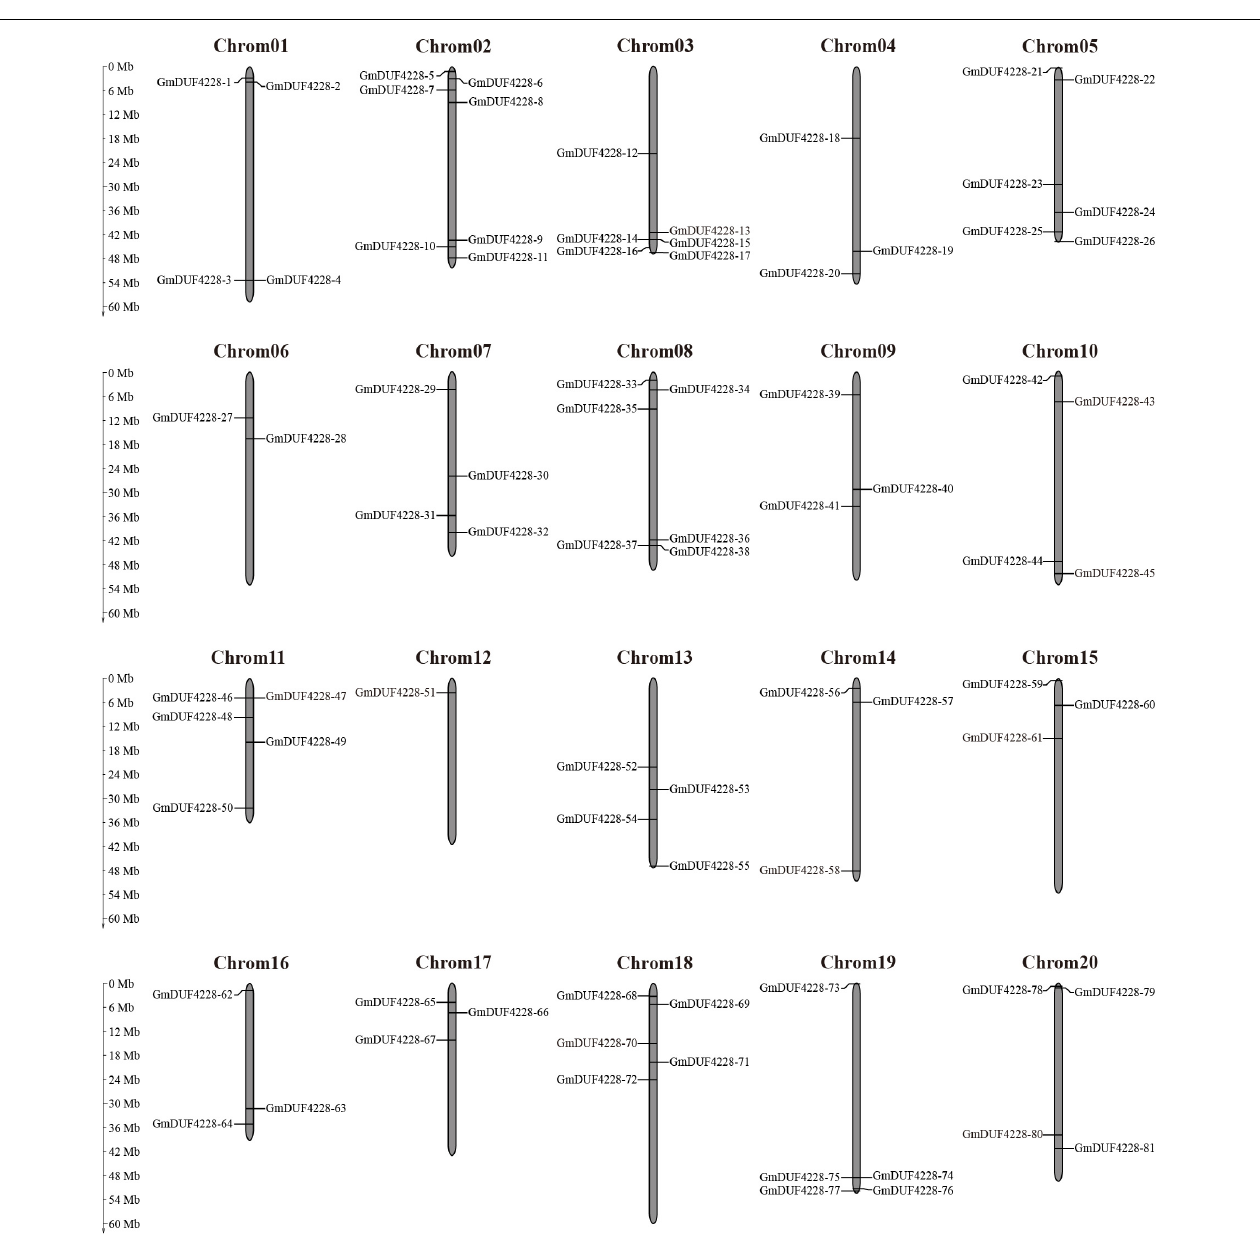
FIGURE 2 | Chromosomal distribution of GmDUF4228 genes. The scale bar indicates the length (Mb) of soybean chromosomes.